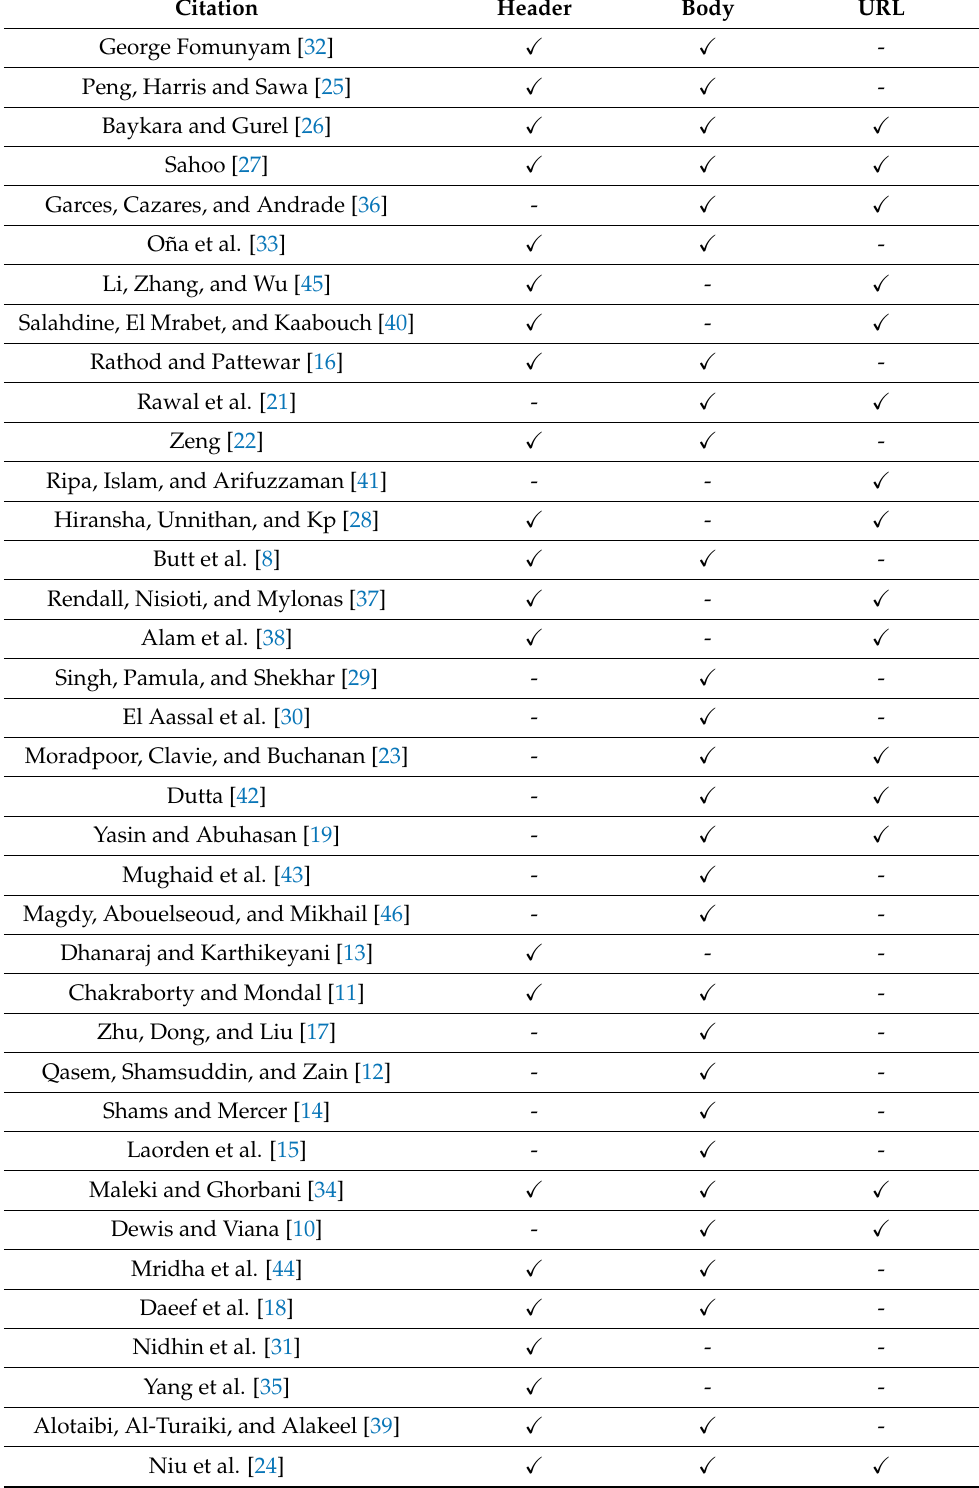
Table 7. Common features used by various researchers to build BEC detection